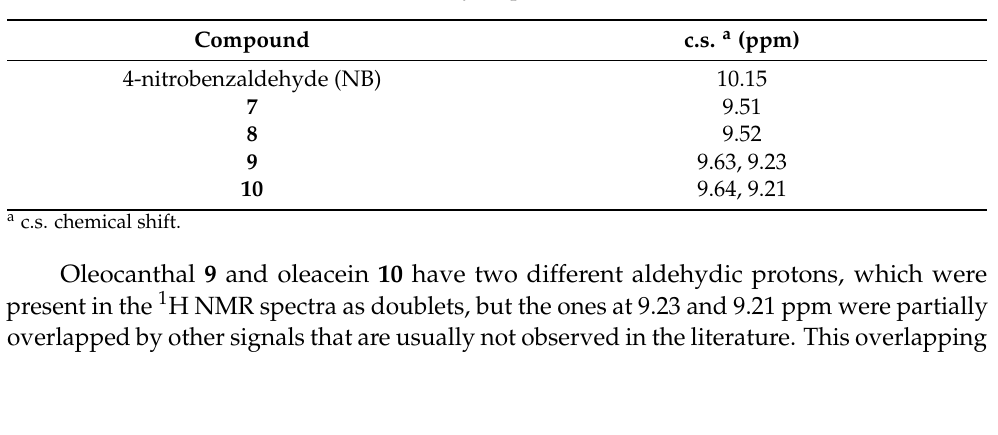
Figure 11. 1 H NMR spectra of oleocanthal 9 in a 1:1 admixture with 4-nitrobenzaldehyde (NB). Figure 11. 1 HNMR spectra of oleocanthal 9 in a 1:1 admixture with 4-nitrobenzaldehyde (NB). Table 1. 1 HNMR chemical shift (c.s.) of aldehydic protons. Table 1. 1 H NMR chemical shift (c.s.) of aldehydic